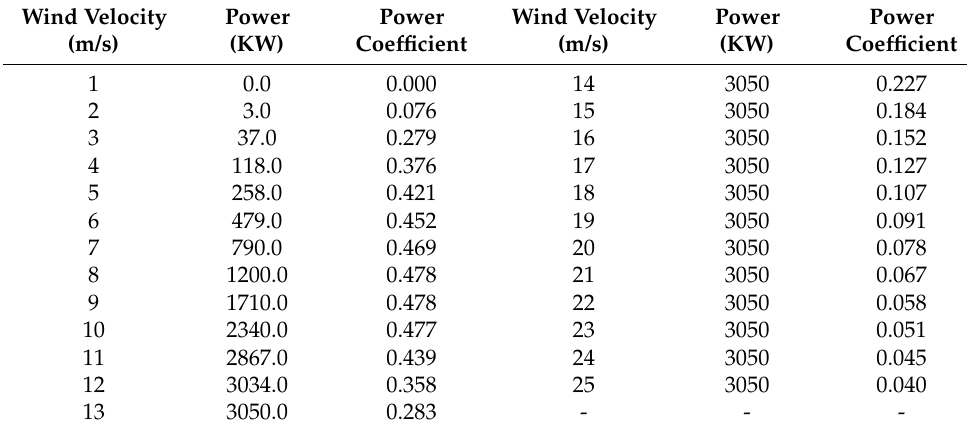
Table 2. Enercon 3 MW E-101 developed from [20].